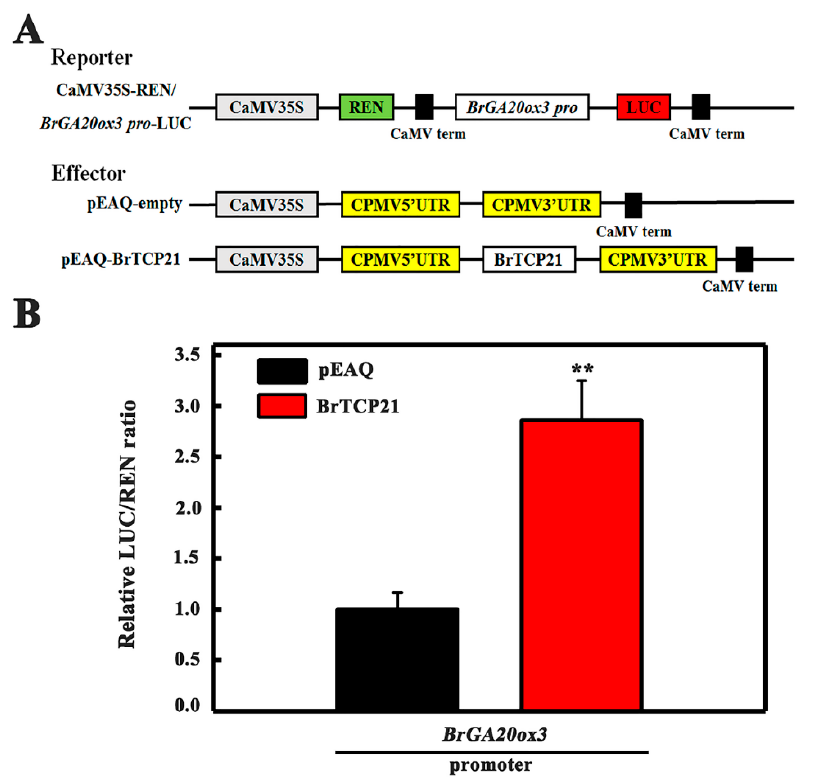
Figure 6. BrTCP21 enhances BrGA20ox3 transcription by transient transcription dual-luciferase Dual- LUC assay in Nicotiana benthamiana leaves. ( A ) Diagrams of the reporter and effector vectors. ( B